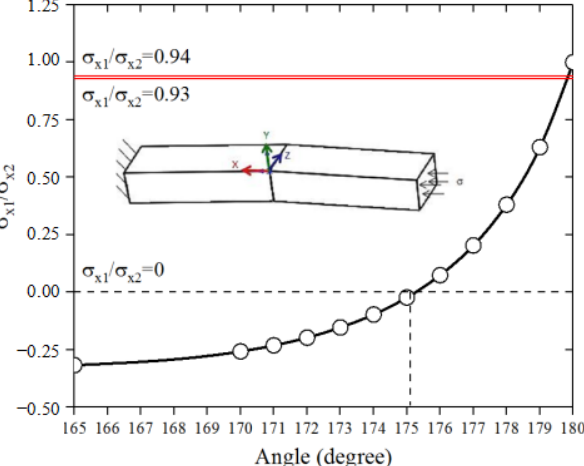
Figure 5. The ratio of external stress to internal stress varies with angle.